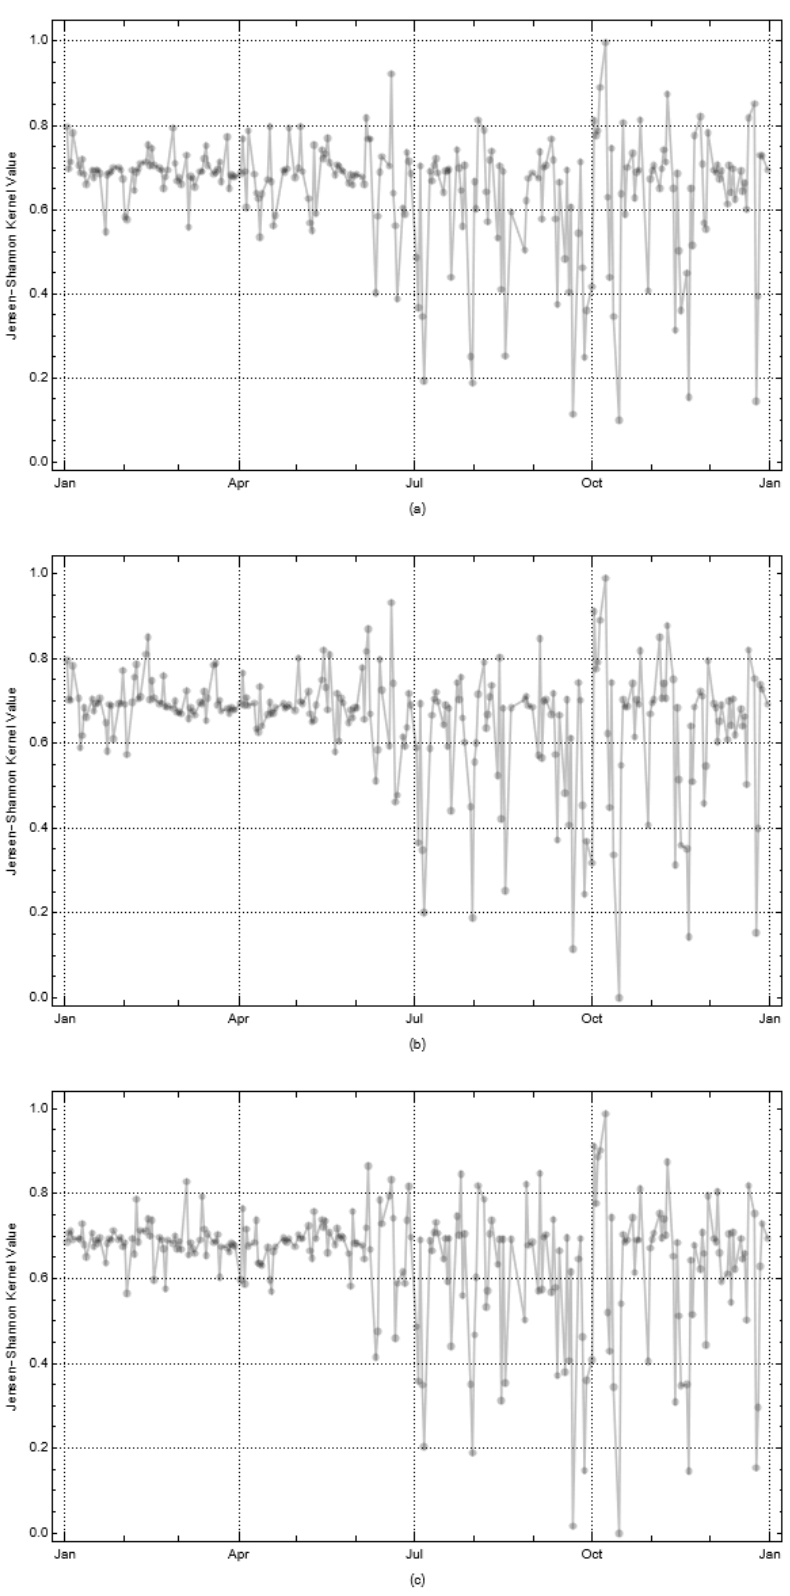
Figure 8. 𝜅 (cid:3011)(cid:3020)(cid:3012)(cid:3020) values defined on the emerging network-induced soft sets for the Figure 8. κ JSKS values defined on the emerging network-induced soft sets for the 2018 economic 2018 economic stress period: ( a ) weekly, ( b ) biweekly, ( c ) triweekly. stress period: ( a ) weekly, ( b ) biweekly, ( c )